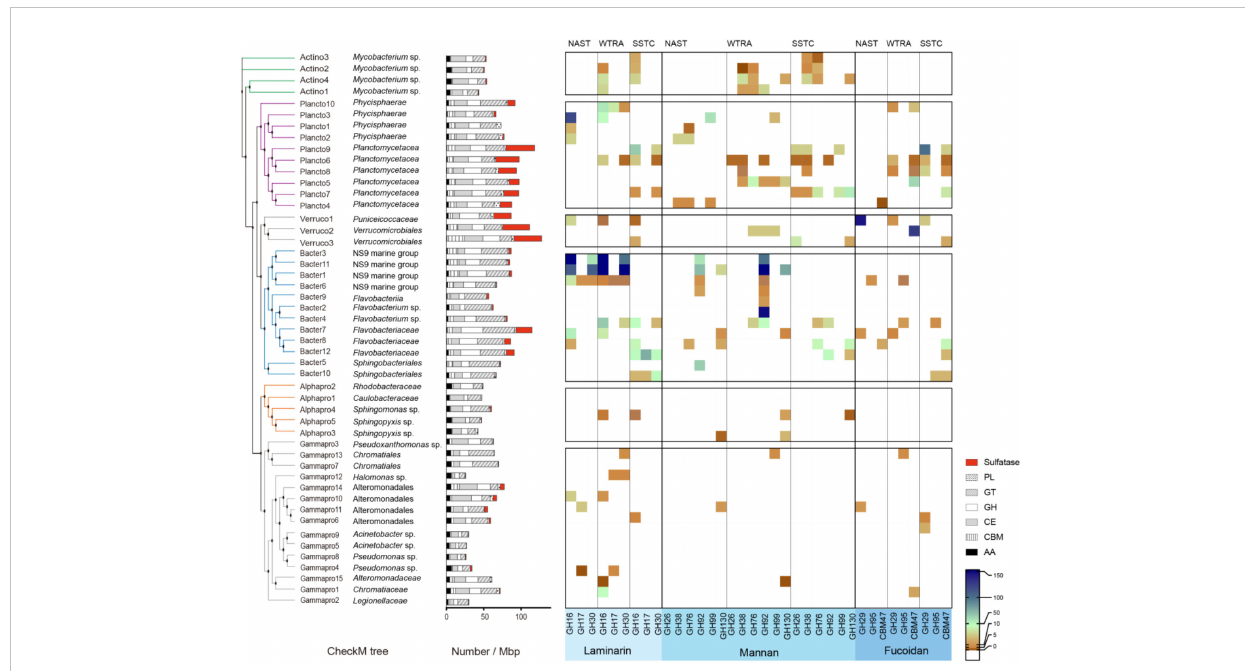
FIGURE 7 Carbohydrate-degradation enzyme pro fi le across reconstructed genomes (MAGs). Heatmap visualises the abundance pro fi les, the number of CAZymes found in a particular MAG related to bin coverage, of glycoside hydrolases responsible for degrading various glycans in each MAG. GT glycosyl transferases, GH glycoside hydrolases, CE carbohydrate esterases, CBM carbohydrate binding modules, AA auxiliary activities, PL polysaccharide